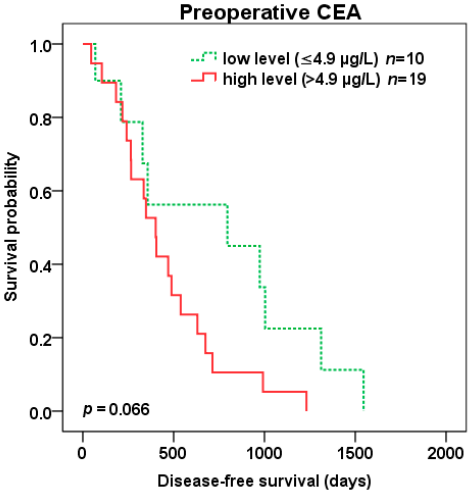
Figure 6. Disease-free survival (DFS) after liver surgery for patients with low (green color dotted line) vs. high (red color) preoperative CEA level (cut-off 4.9 µg/L).